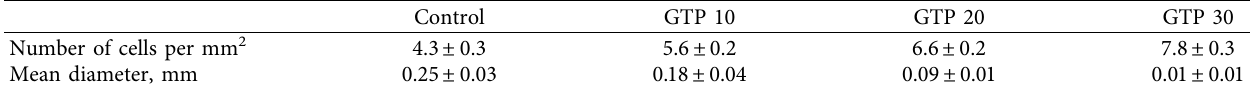
Table 3: Results of image analysis of various sponge cake samples.